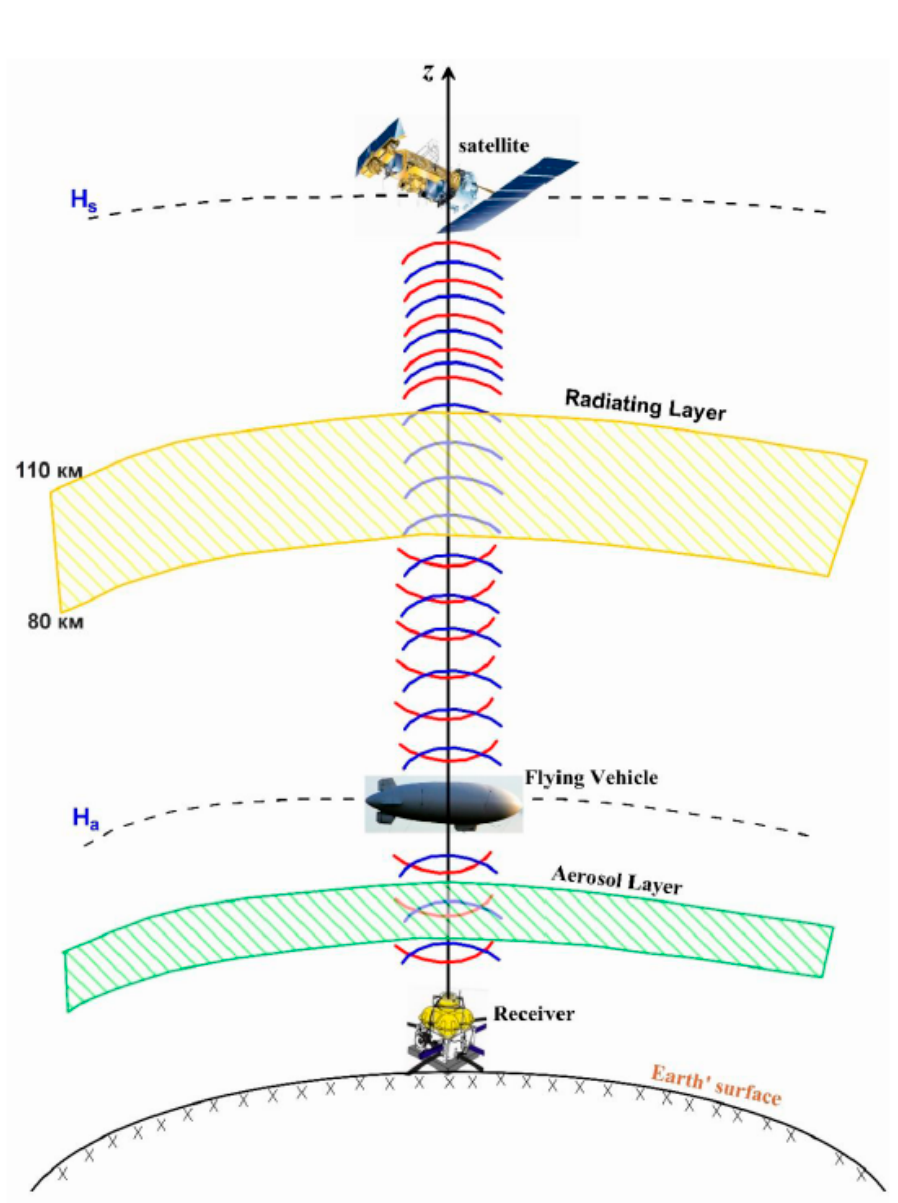
Figure 1. The scheme of measurements by the method of passive remote sensing. Yellow indicates the radiating layer and green indicates the charged aerosol layer. Red lines along the vertical axis are direct radiation up and down from the D and E ionospheric layers; blue lines are radiation reflected from the Earth’s surface. Dotted lines H s and H a set the trajectory of the satellite and airship.